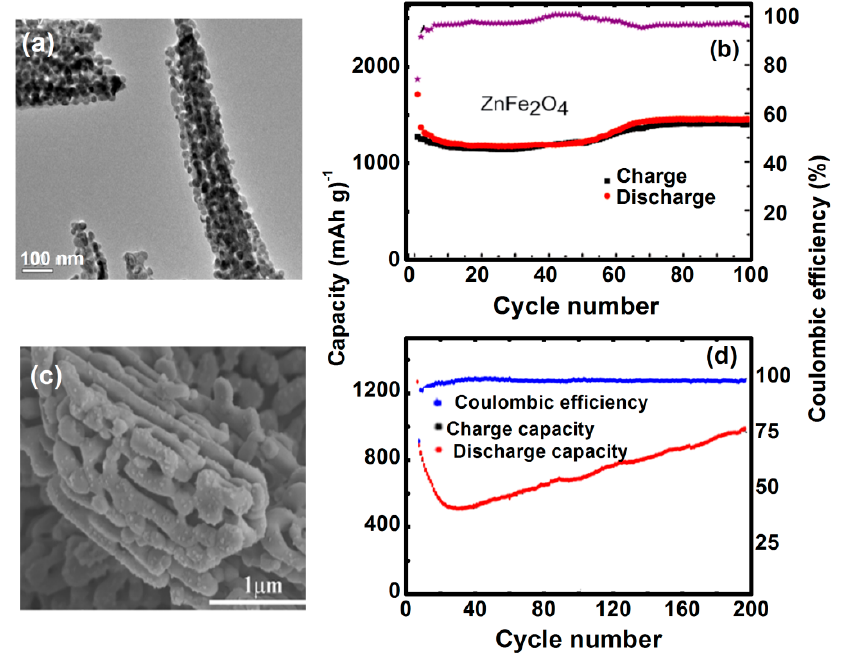
Figure 14 ( a ) TEM image of ZnFe 2 O 4 . ( b ) Cycle performances and Coulombic efficiencies (CE) of ZnFe 2 O 4 at a current density of 100 mA g − 1 (Reproduced with permission from [77]. Copyright Royal Society of Chemistry, 2015). and ( c ) SEM image of ZFPE-15 and ( d ) cycle performances and Coulombic efficiencies (CE) at a current density of 1A g − 1 (Reproduced with permission from [86]. Copyright Elsevier, 2020).